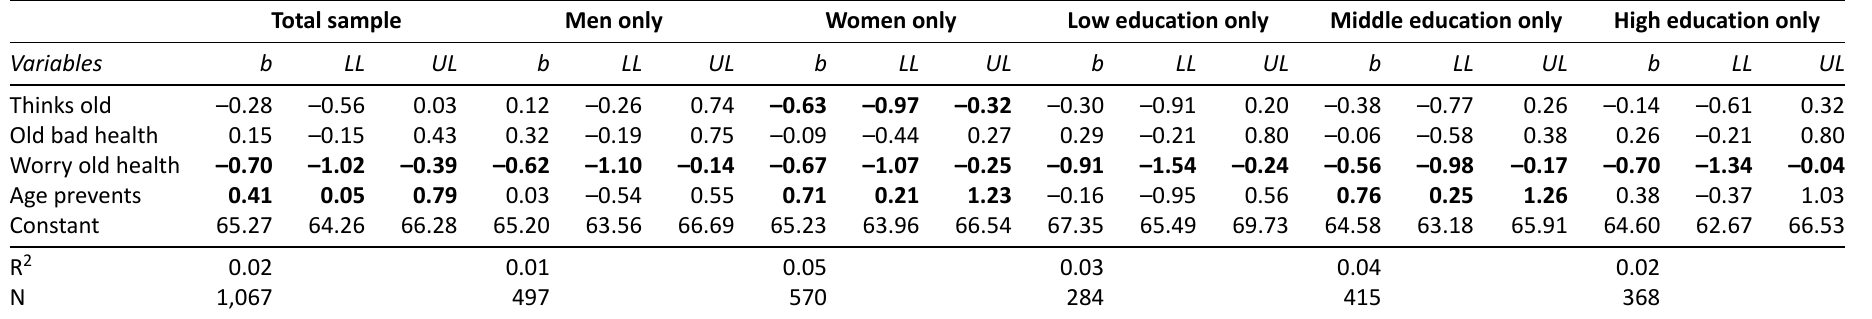
Table A1. Preferred retirement age wave